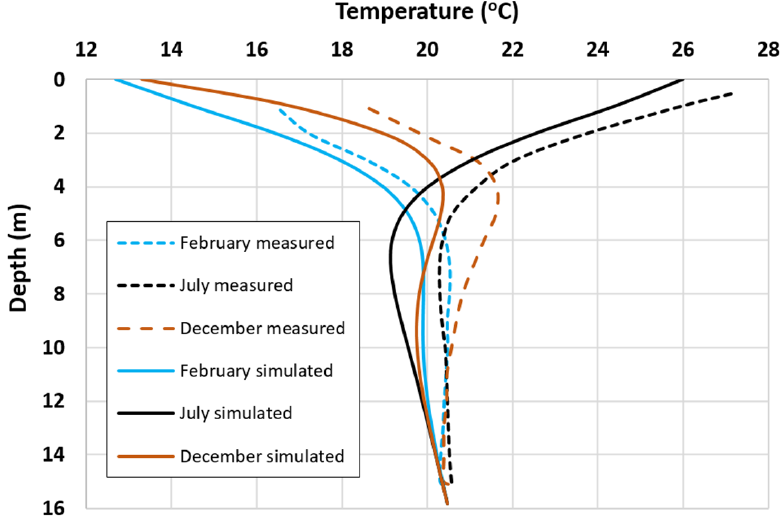
Figure 10. TDPTS simulated with no groundwater flow vs. TDPTS measured.